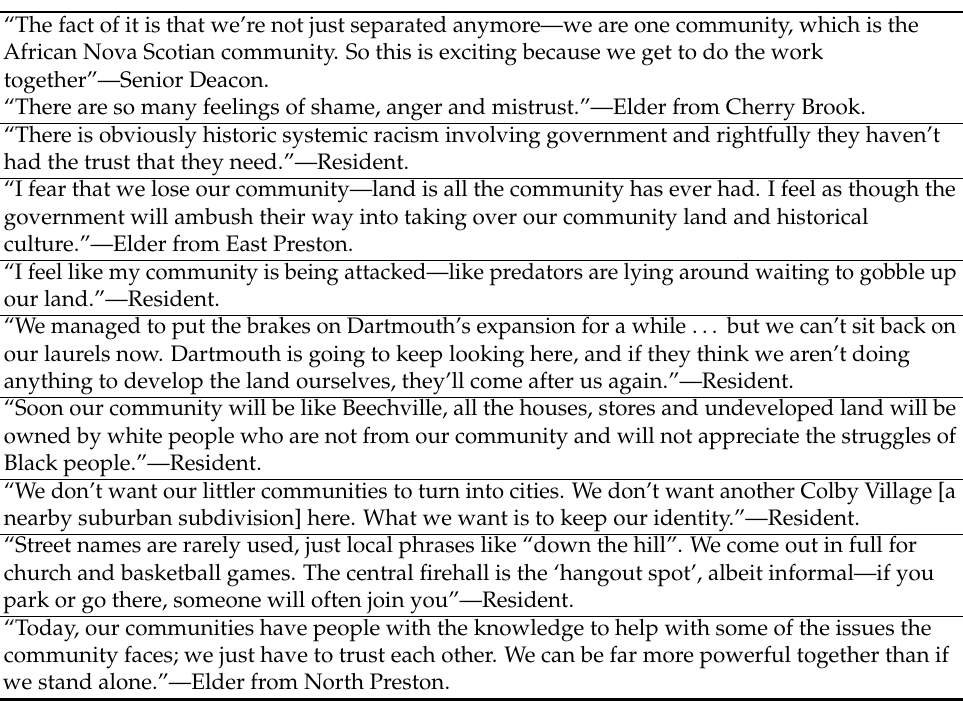
Table 3. Community members’ statements and landscape change perspectives. Sources: (Waldron 2016, 2018; Porter 2017; Simmonds 2014; Sehatzadeh 2008; Whitfield 2008; Este 2007; Saney